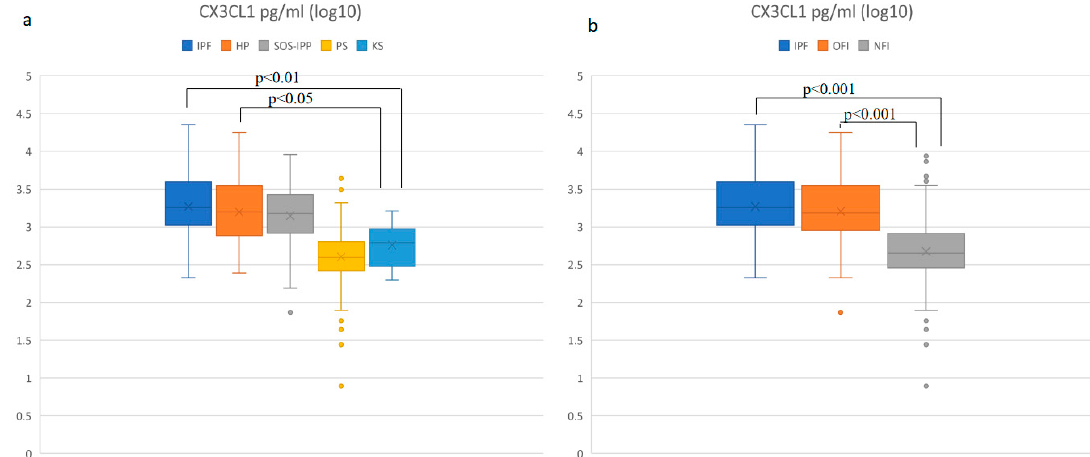
Figure 1. Comparison (log10) of the CX3CL1 concentration in BALF: ( a ) in DPLD groups and control group, ( b ) in idiopathic pulmonary fibrosis (IPF), other fibrosis than IPF group (OFI) and non-fibrosis group (NFI). Idiopathic pulmonary fibrosis (IPF)—median: 1803.3 pg/mL, interquartile range (IQR): 2668.7; hypersensitivity pneumonitis (HP)—median: 1566.0 pg/mL, IQR: 2708.2; connective tissue disease-associated interstitial lung disease (CTD-ILD)—median: 1502.9 pg/mL, IQR: 2131.8; pulmonary sarcoidosis (PS)—median: 393.9 pg/mL, IQR: 373.6; control group (CG)—median: 616.8 pg/mL, IQR: 633.4; OFI—median: 1443.8 pg/mL, IQR: 2457.4; NFI—median: 448.7 pg/mL, IQR: 529.0.